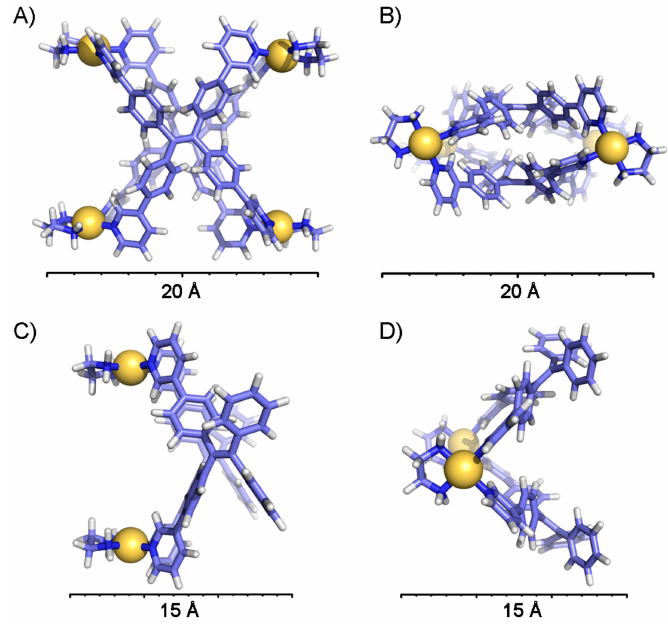
Figure 2. Simulated molecular structure models for complexes 1 ( A , B ) and 2 ( C , D ). Color scheme: C, slate sticks; H, white sticks; N, blue sticks; Pd, yellow